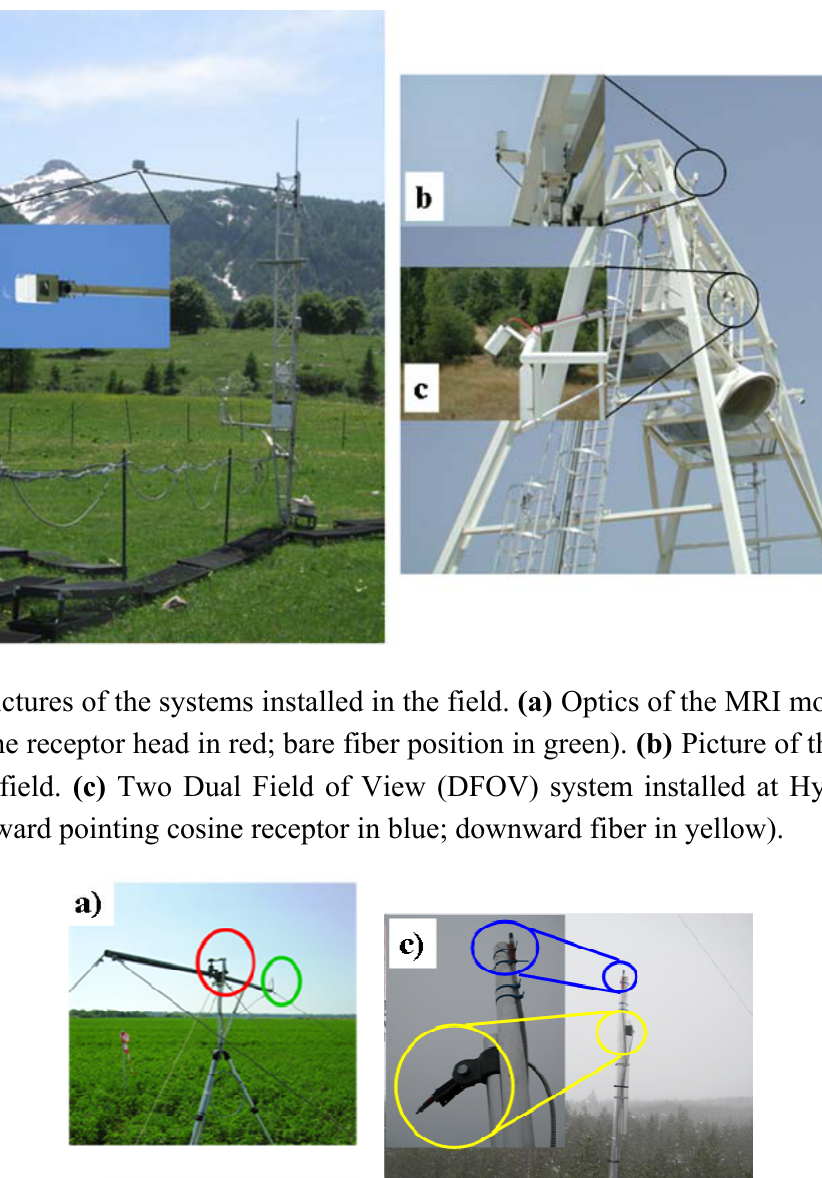
Figure 3. (a) Cropscan MSR16R sensor mounted at Monte Bondone grassland site (IT-MBo); (b-c) The two CIMEL radiometers mounted at the SMOSREX experimental grassland site (FR-Mau): (b) upward sensor, (c) downward sensor.